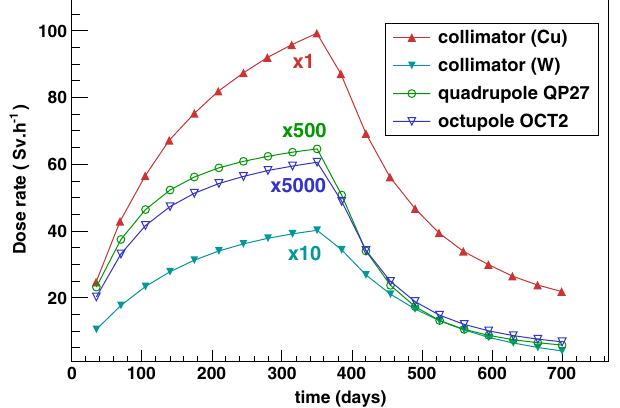
FIG. 13. Time evolution of dose rates calculated at 1 m from the element surface for 365 days of exposure for various